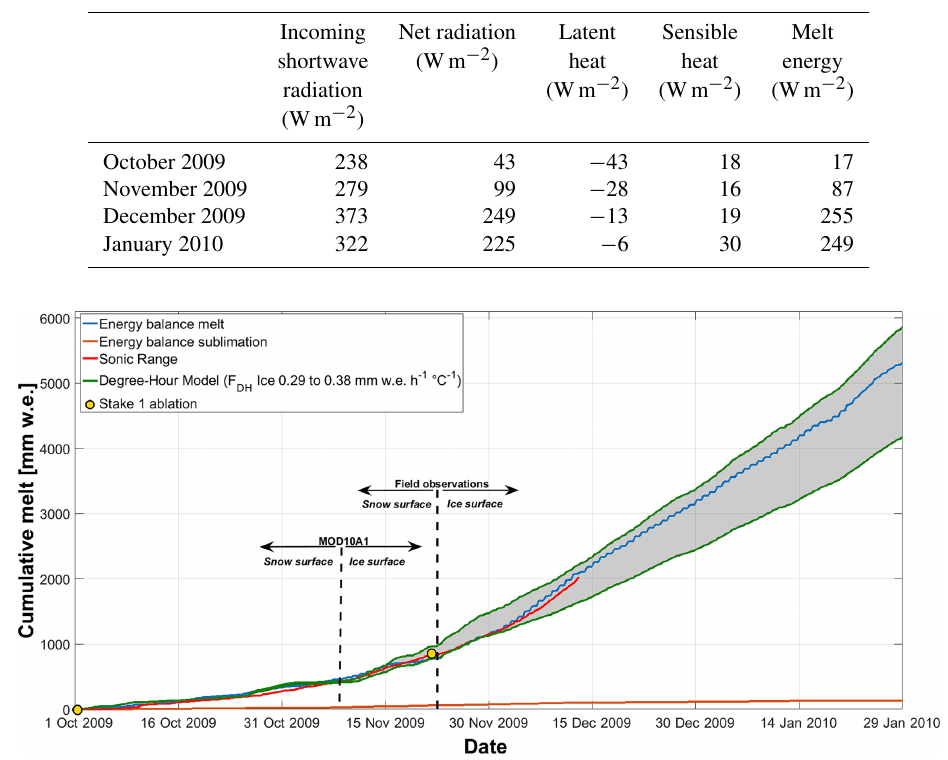
Figure 7. Comparison of cumulative melt estimated by the point-scale degree-hour model (grey area between green lines), point-scale energy balance model, sonic ranger and stake 1 located near AWS1